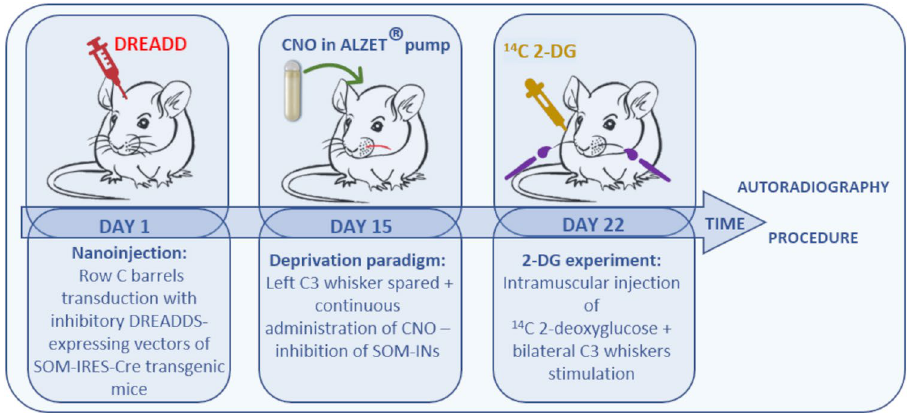
Figure 1. Experimental scheme and timeline. Two weeks after nanoinjection of DREADDs-expressing viral vectors, mice started a one-week-long sensory deprivation paradigm (Day 15), in which all but C3 whisker on the left side of the snout were trimmed (whiskers on the right side of the snout remained untouched) and CNO (1 mg/ml) or sterile saline (0.9%) were administered by micro-osmotic pump during the whole procedure. One day after the end of deprivation (Day 22), 2-deoxyglucose (2-DG) mapping was performed, followed by